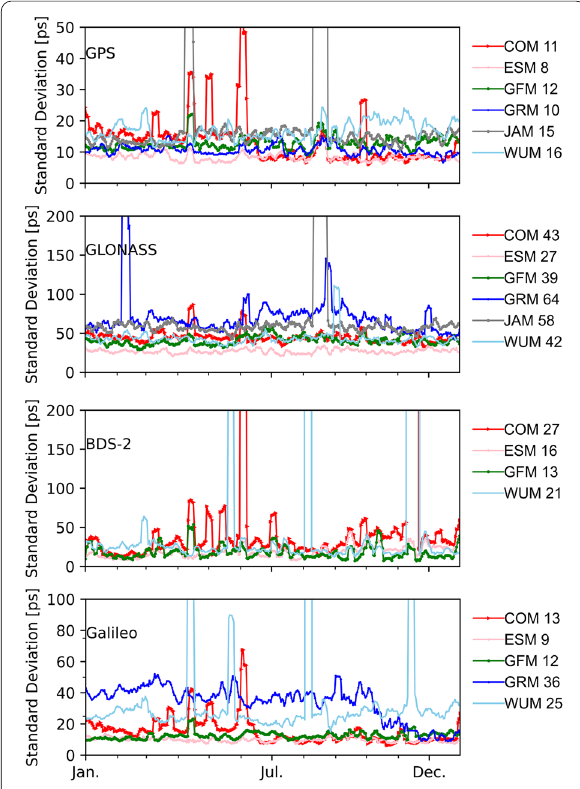
Fig. 7 STDevs of the GPS, GLONASS, BDS-2 and Galileo satellite clocks for different ACs in 2018. The daily STDevs are smoothed with a moving window with a 7-day width, and the values in the legend are the median STDevs